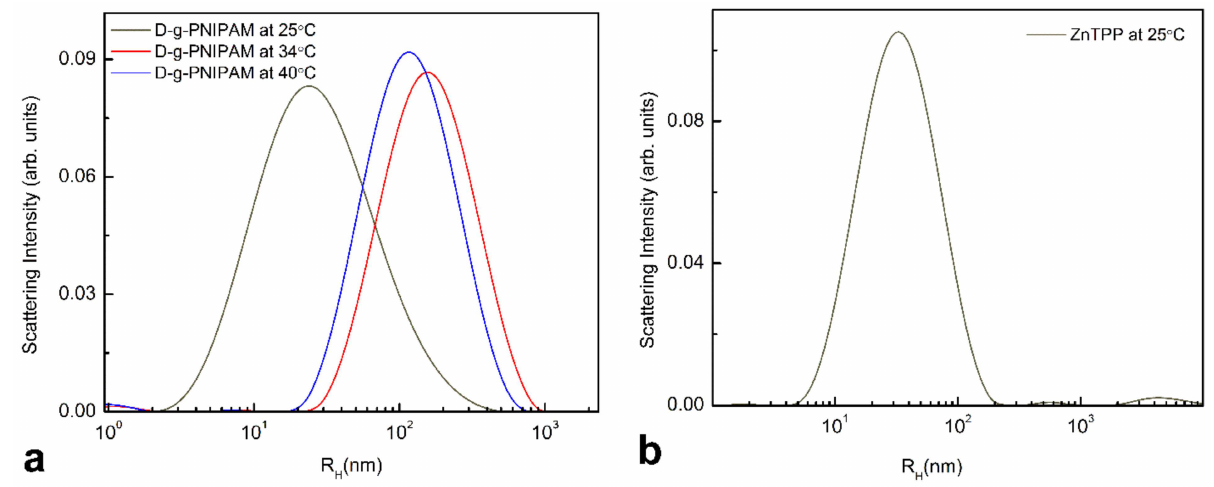
Figure 3. ( a )—PSD of D-g-PNIPAM aqueous solution at temperatures lower (25 ◦ C), equal (34 ◦ C) and higher (40 ◦ C) than LCST point. ( b )—PSD of ZnTPP in ethanol mixed with water at 25 ◦ C.